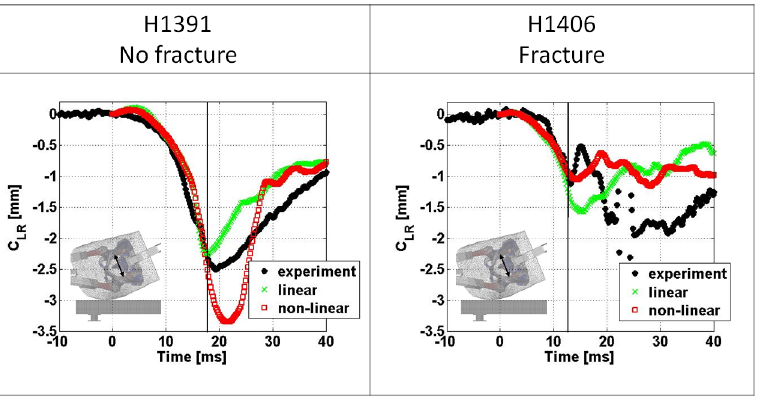
Fig 5. Comparison of pelvic ring deformation over time between experimentally and both linear and non-linear FEM derived results. The vertical lines indicate the time of experimentally measured peak impact